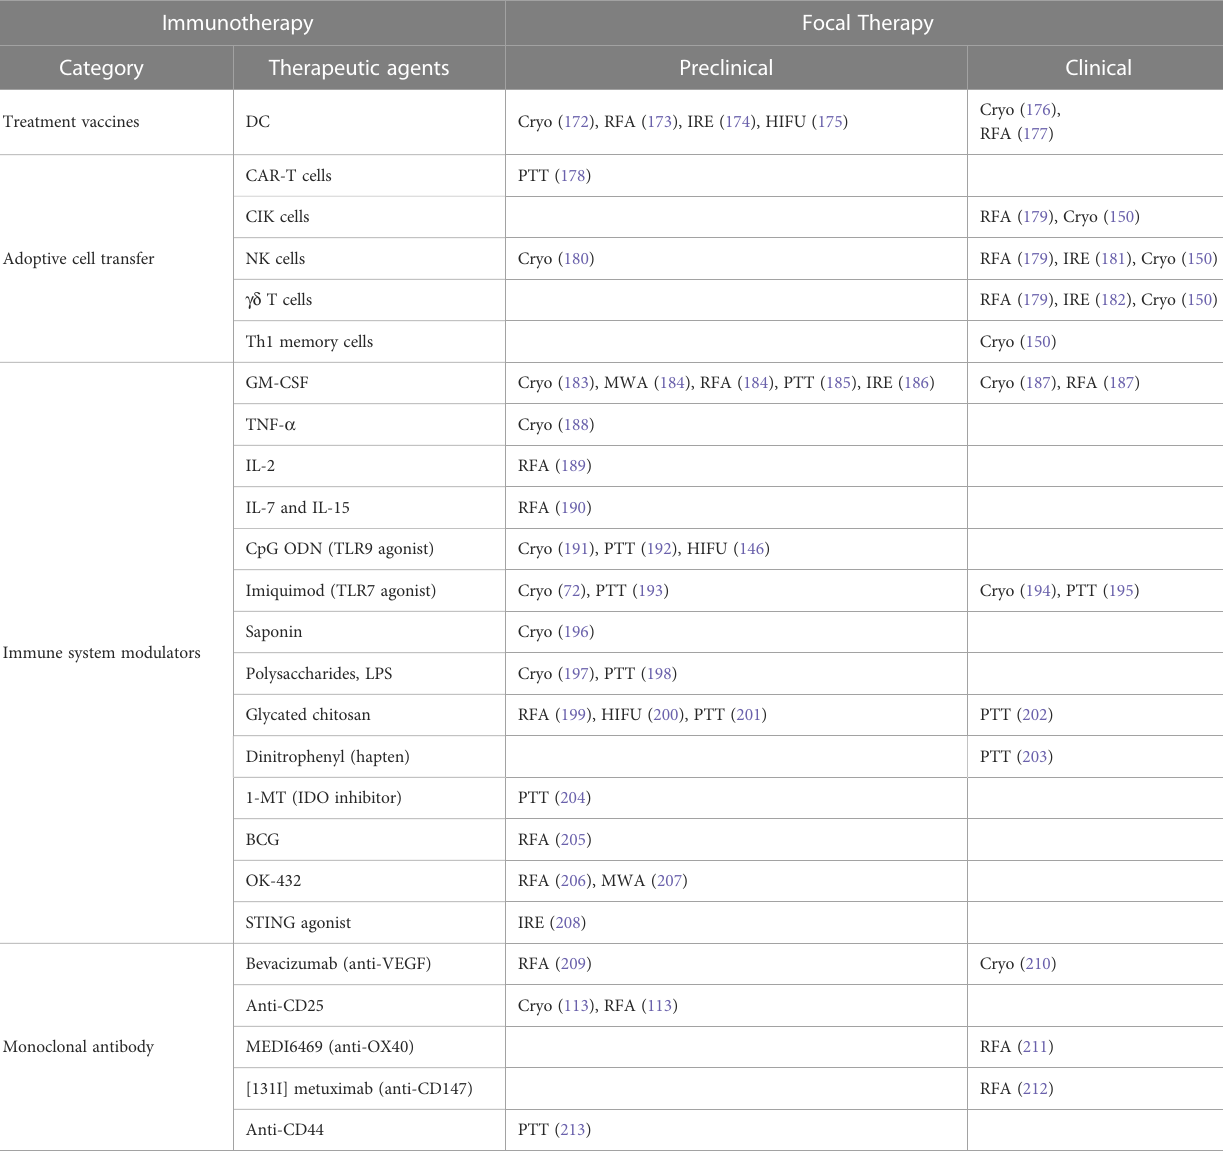
TABLE 6 Selected examples of studies combining immunotherapy (except for ICIs, which is discussed in section 6) and focal therapy.